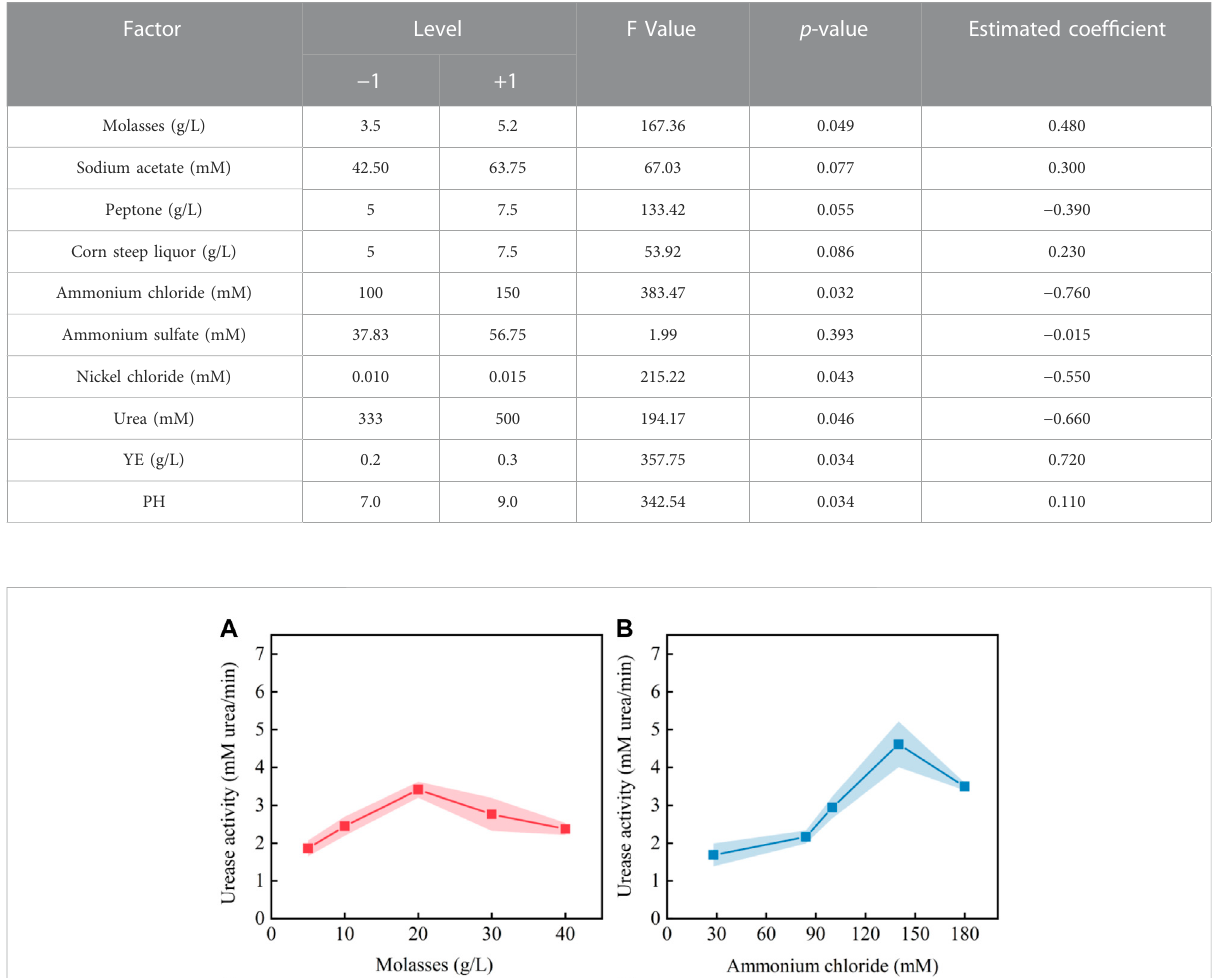
TABLE 2 Results of PB design.